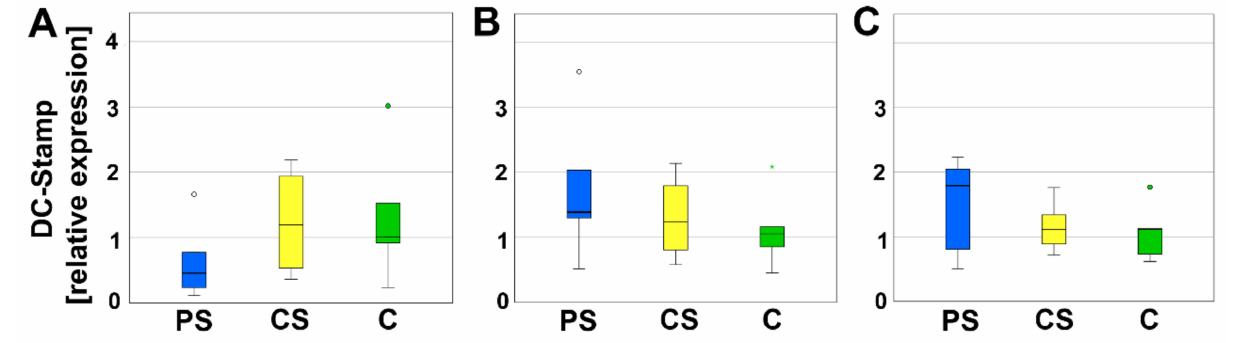
Figure 5. Relative expression of DC-Stamp after 4 ( A ), 8 ( B ), and 12 days ( C ). Circles and small asterisks denote outliers.